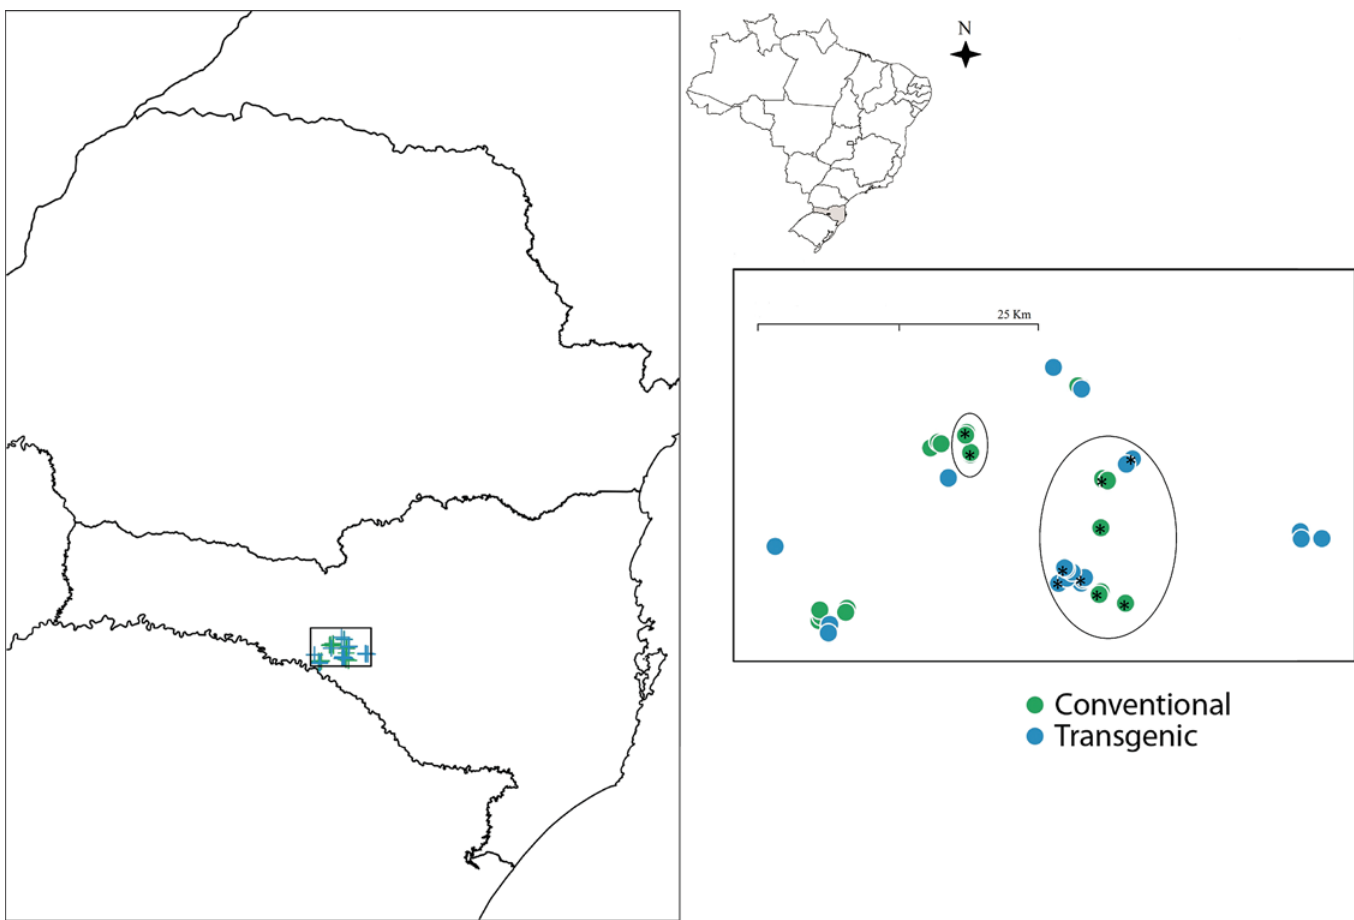
Fig 1. Map of the study region. Location of the 40 forest fragments in the Campos Novos, Santa Catarina state, southern Brazil, near conventional or transgenic maize crops. The twenty fragments sampled in the first year (2013) are